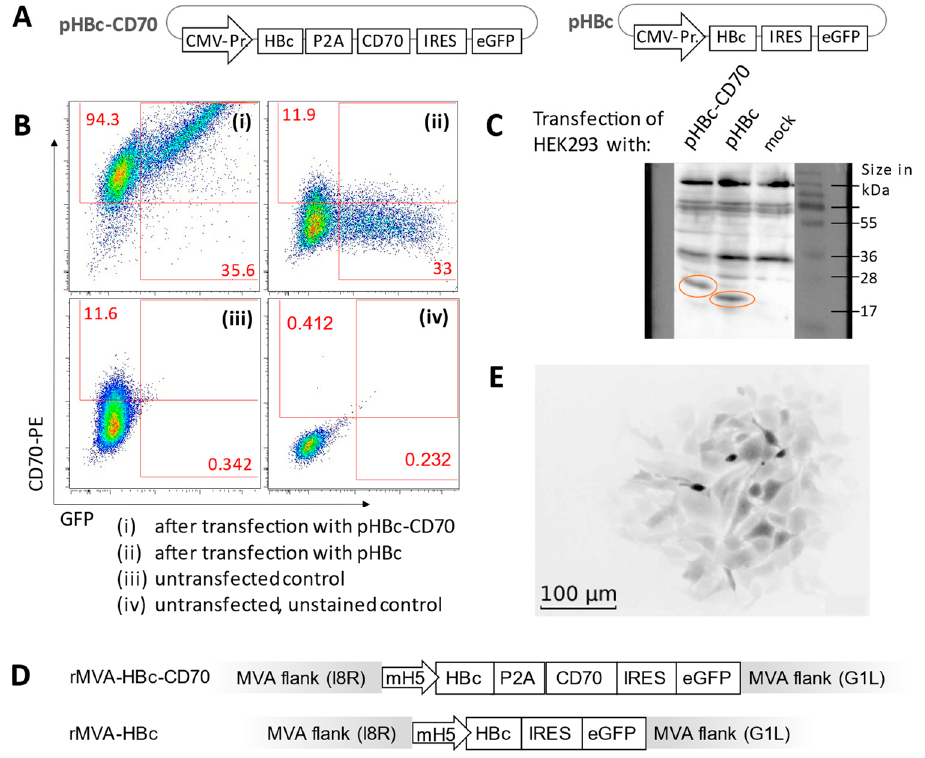
Figure 1. Generation of recombinant MVA vectors encoding the transgenes HBV core antigen (HBc), the reporter GFP and the co-stimulatory molecule CD70. ( A ) Schematic illustration of the plasmids pHBc-CD70 and pHBc containing the respective gene expression cassettes under control of a CMV-promoter/enhancer element. ( B ) HEK293 cells transfected with pHBc-CD70 or pHBc were stained with anti-CD70-PE (except lower right unstained control) and showed a positive correlation of CD70 and GFP co-expression (upper left). ( C ) Western blot analysis of HBV core proteins in supernatants from non-transfected (lane 3, “mock”) or from pHBc-CD70 or pHBc transfected HEK293 cells (lane 1 and 2). The circled bands indicate the HBV core protein (21 kDa) and core plus remaining aminoacids added by the P2A site (21 plus 2.1 kDa). ( D ) Gene expression cassettes of rMVA-HBc-CD70 and rMVA-HBc, which was introduced in the wildtype MVA genome by spontaneous homologous recombination with shuttle plasmids in DF-1 cell culture. The gene expression cassette is located between the essential MVA genes I8R and G1L. ( E ) Amplification of recombinant MVAs resulted in green fluorescent spots on the DF-1 cell layer detected by immunofluorescence microscopy (visible here in darker shades of grey). This allowed positive selection and removal of residual wildtype MVA and production of pure recombinant MVA. CMV-Pr.: CMV-Promoter; mH5: mH5 promoter; HBc: sequence for HBV nucleocapsid protein HBV core; P2A: self-cleaving site; IRES: internal ribosomal entry site; eGFP: sequence for enhanced fluorescent protein.